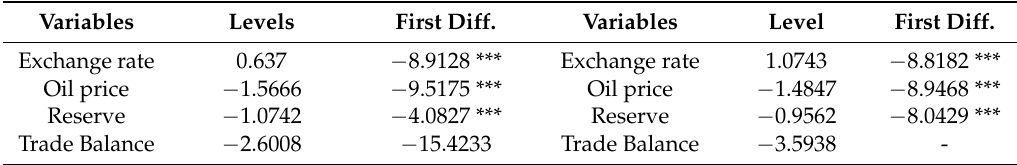
Table 5. Augmented Dickey–Fuller and